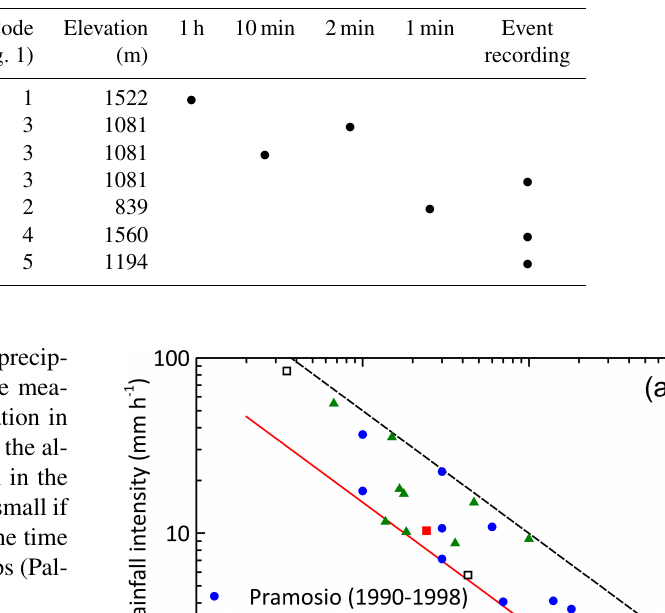
Table 4. Rain gauges in the Moscardo basin: years of operation and recording intervals. The rain gauges numbers in the second column refer to the map of Fig. 1.